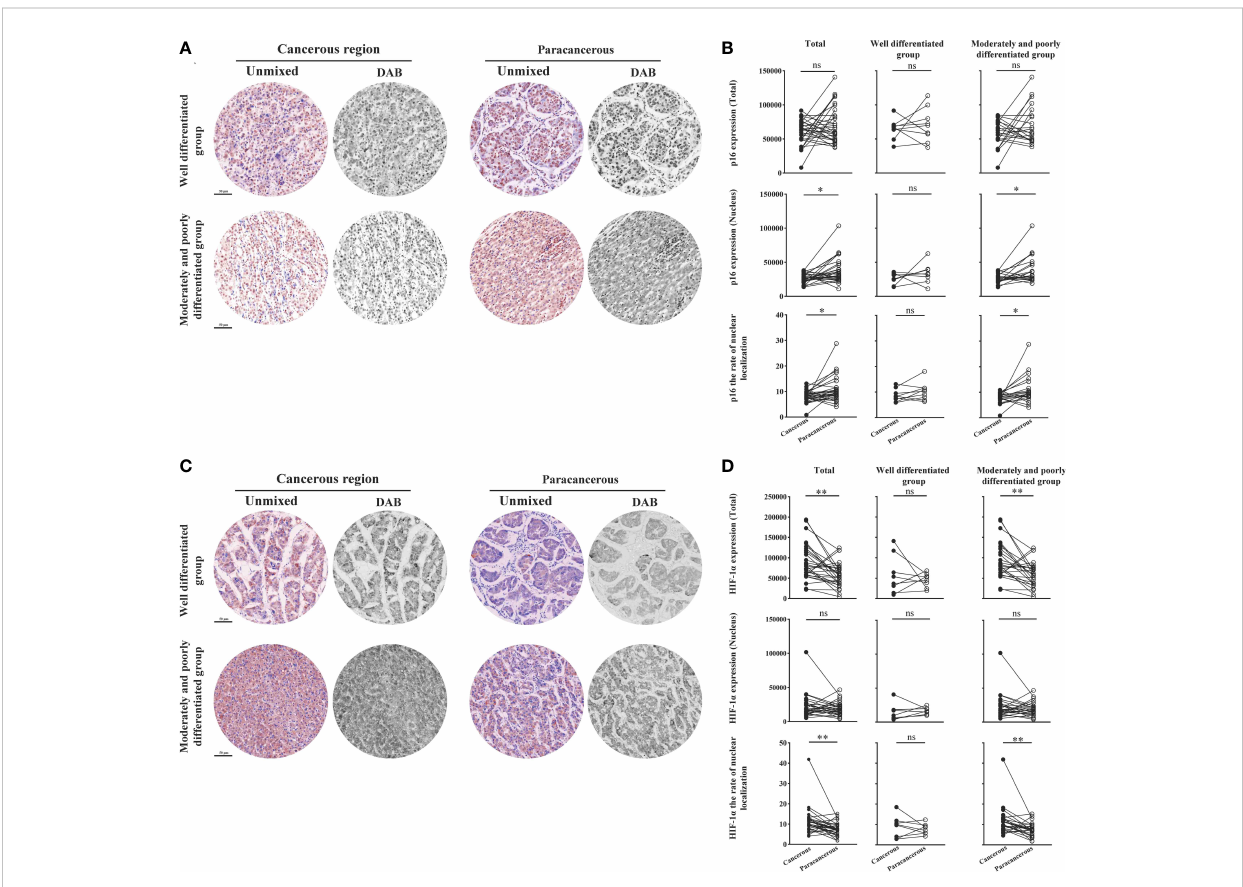
FIGURE 7 Immunohistochemical staining of p16 and HIF-1 a proteins in liver cancer tissues and their quantitative images. (A) Representative image of immunohistochemical staining of the p16 protein in liver tissues. (B) Quantitative multispectral image of the p16 protein. (C) Representative image of immunohistochemical staining of the HIF-1 a protein in liver tissues. (D) Quantitative multispectral image of the HIF-1 a protein. The experimental data are expressed as the mean ± SEM. Compared to paracancerous regions, * p < 0.05; ** p < 0.01. Scale bar, 50 µm. ns, not